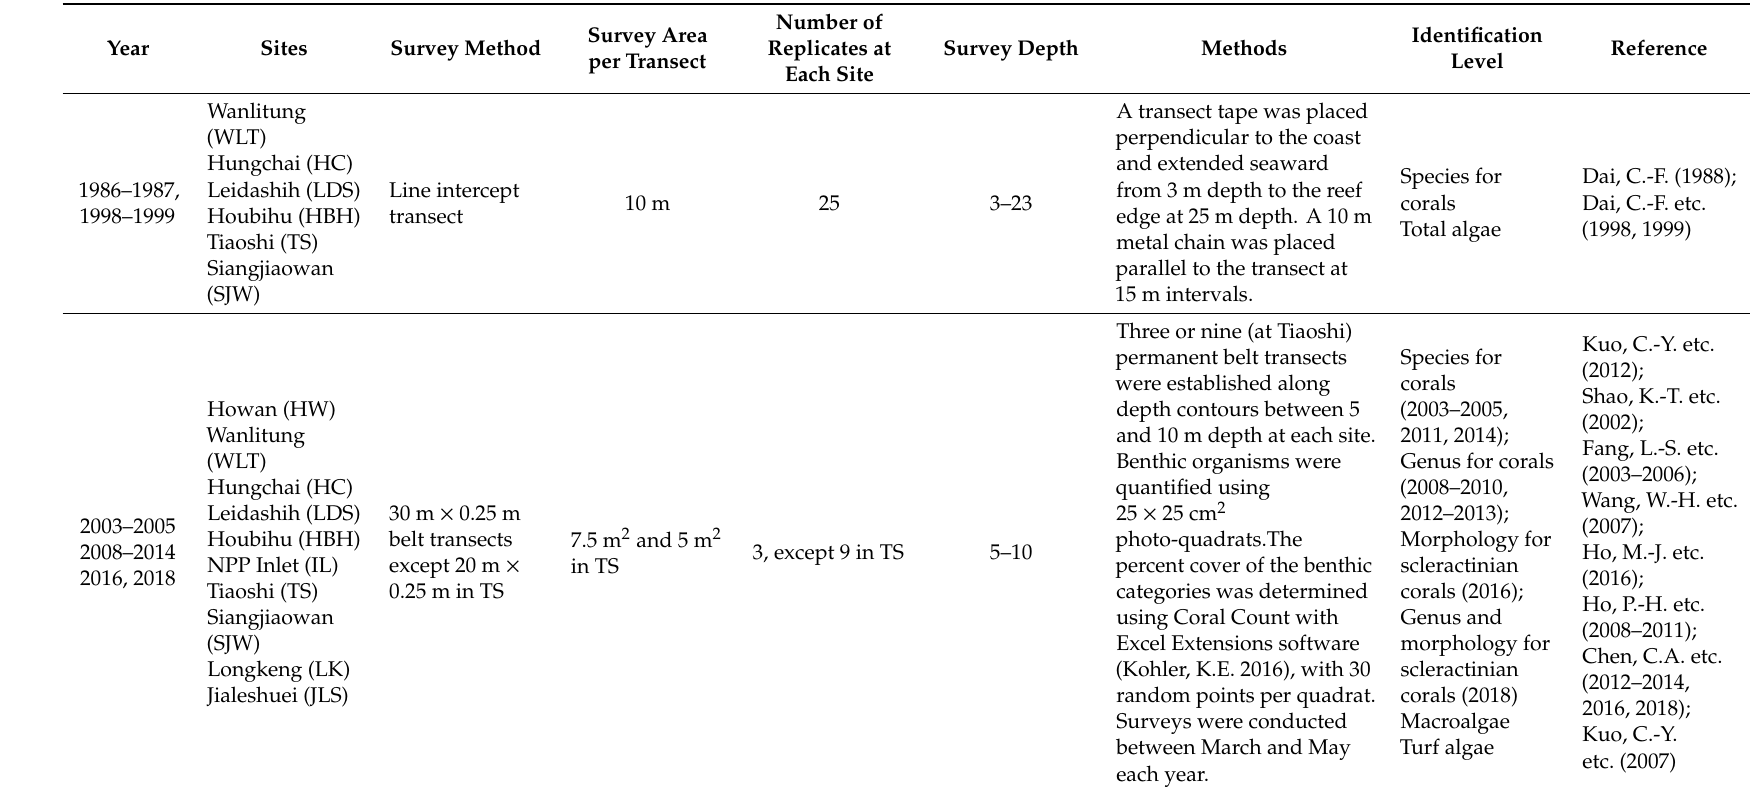
Table 1. Summary of the historical dataset conducting National Park-wide qualitative survey since